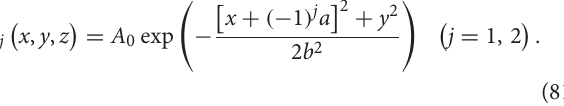
Frontiers in Physics |